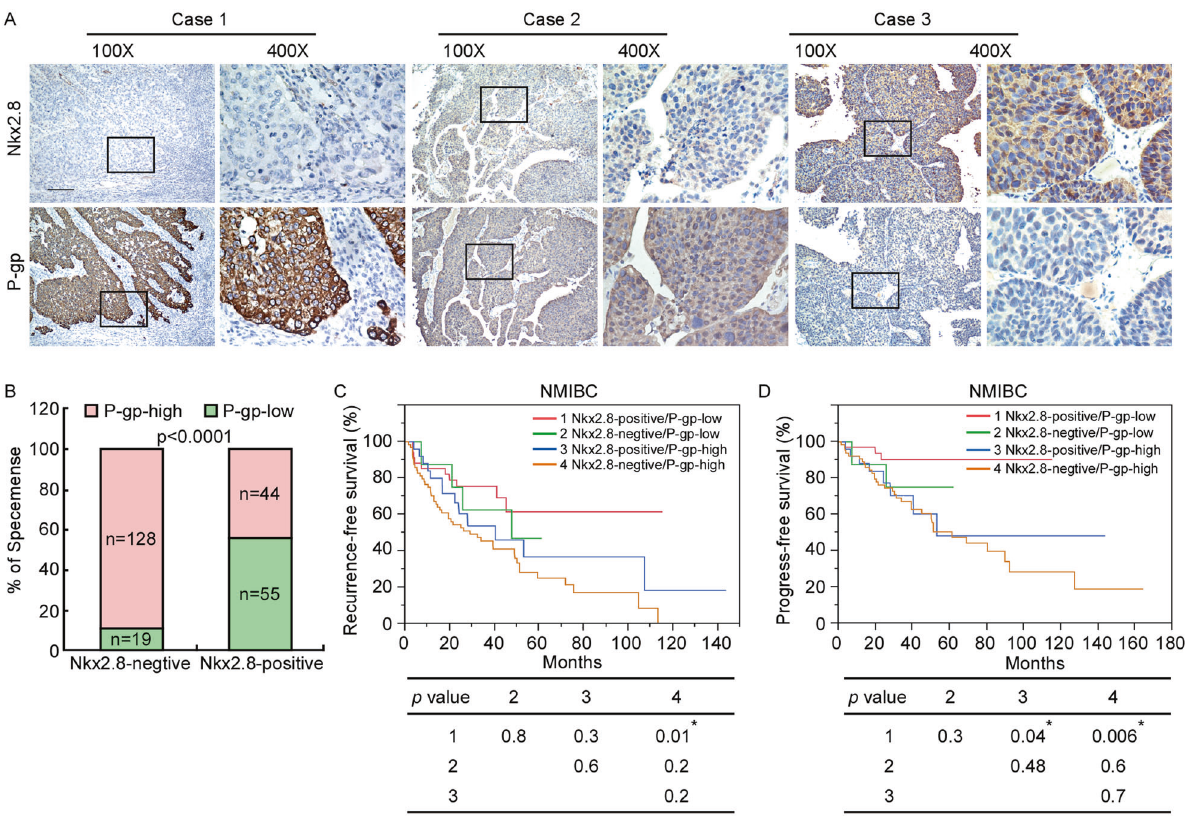
Fig. 7 Clinical relevance of Nkx2.8 and Twist1 in human UC. A Nkx2.8 levels were negatively associated with P-gp expression in 246 human UC specimens. Three representative cases are shown (scale bar, 200 μ m). B Percentage of UC specimens showing negative or positive Nkx2.8 expression relative to the level of P-gp. p values are indicated (chi-square test). C Comparison of the RFS times of NMIBC patients with different levels of Nkx2.8 and P-gp expression combination. p values are indicated (log-rank test). D Comparison of the PFS times of NMIBC patients with different levels of Nkx2.8 and P-gp expression combination. p values are indicated (log-rank